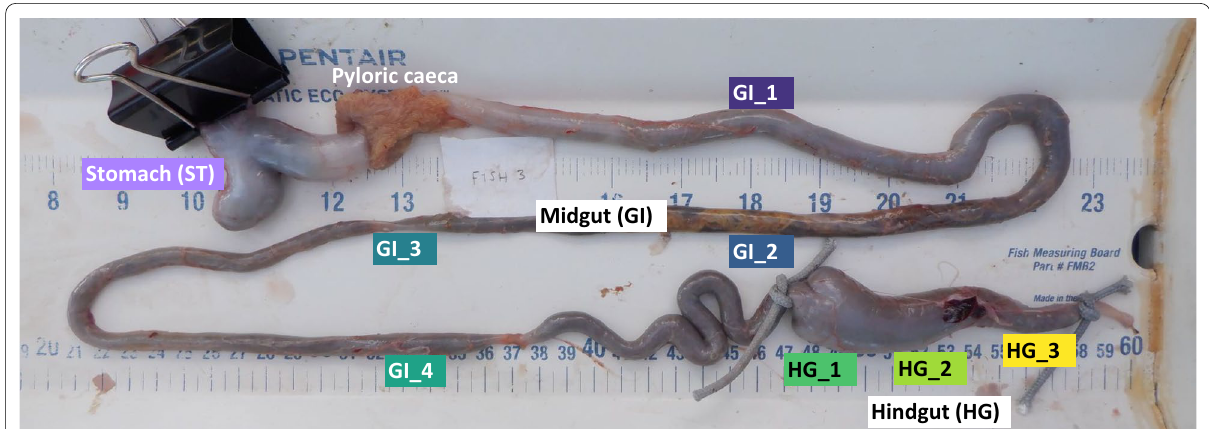
Fig. 1 Fine-scale longitudinal sampling of the nenue gastrointestinal tract. The gut was subdivided and sampled in 8 gut subsections. Each gut subsection is colored according to its position in the gut with darker colors indicating more anterior and lighter colors indicating more posterior. Samples were taken from 5 fish of the Kyphosus